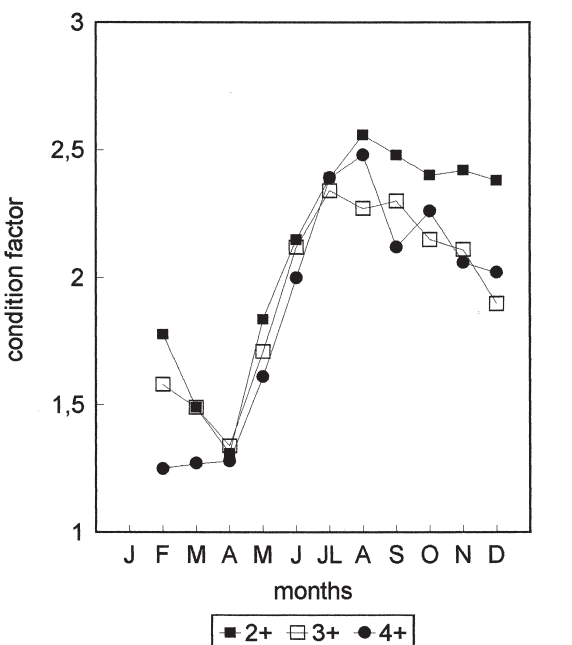
F IG . 6. – Monthly profile of water temperature in the Albufera des Grau